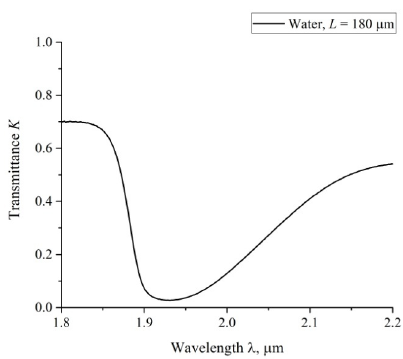
Figure 4. The spectrum of transmittance, K , for water in the range 1.8 < λ < 2.2 µ m; the distance between the cell windows L = 180 µ m.